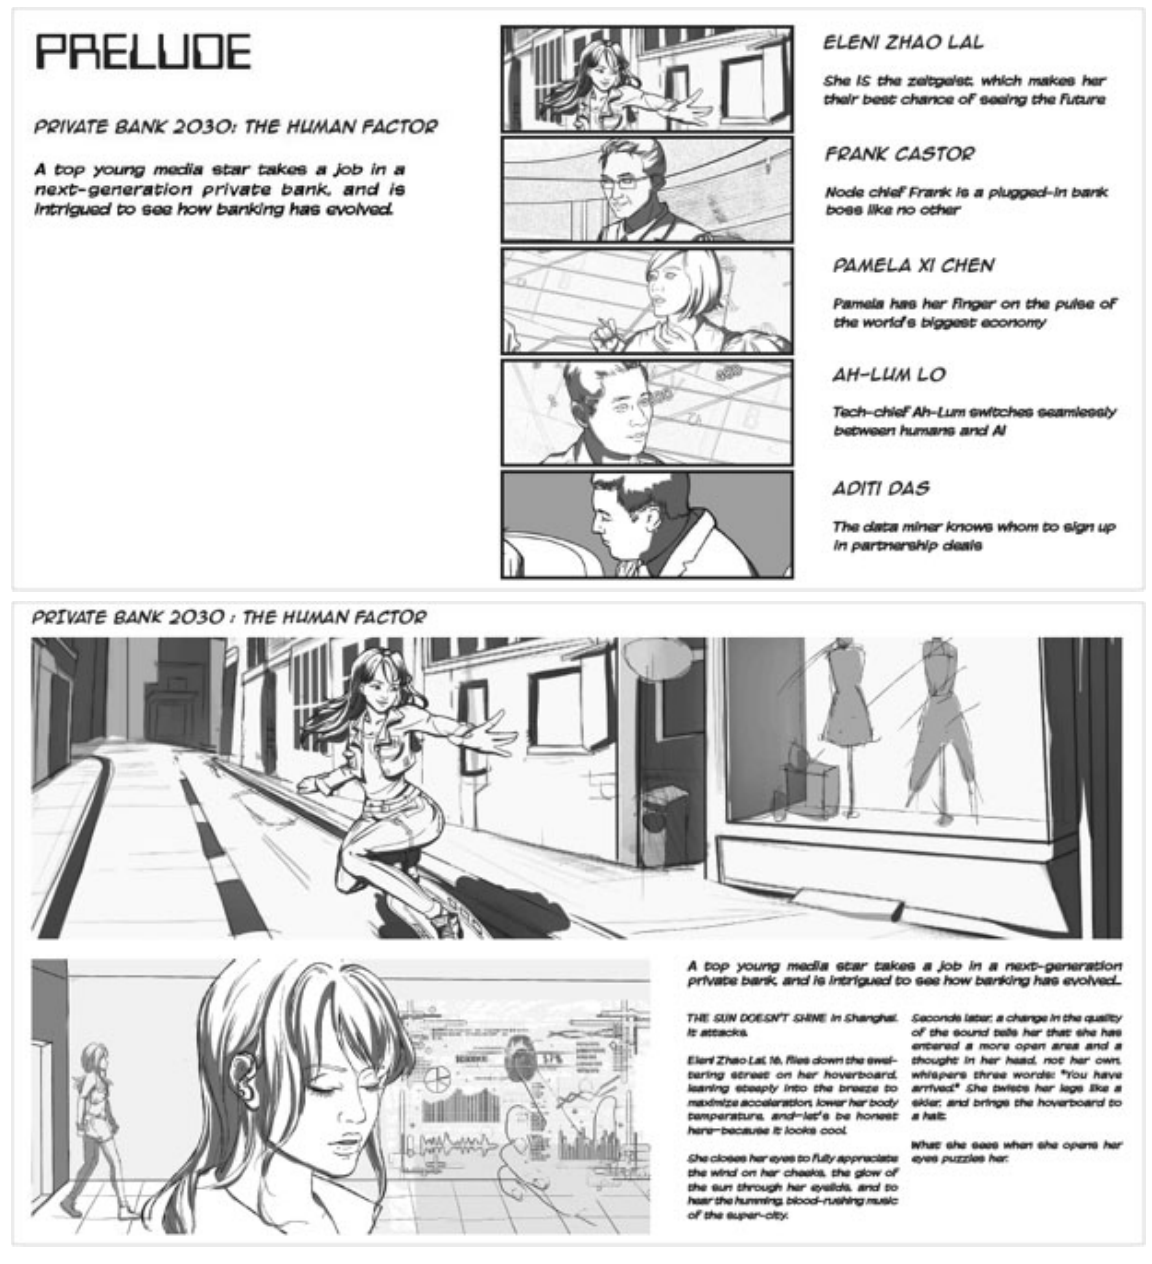
Fig. 3. Data visualization in form of storytelling persona and narratives